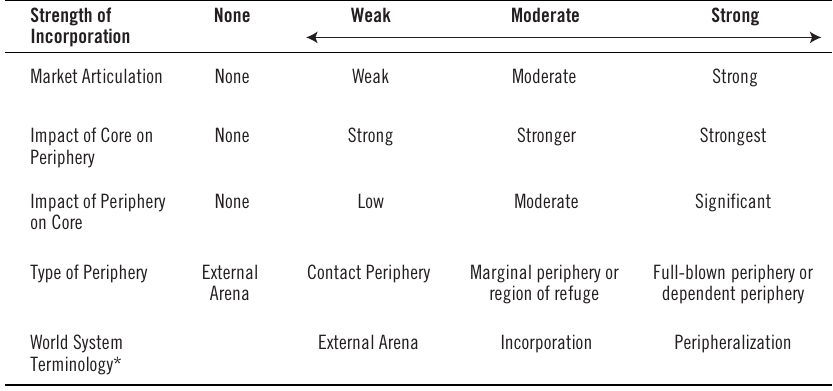
Figure 1 – Hall’s “Continuum of Incorporation and Associated